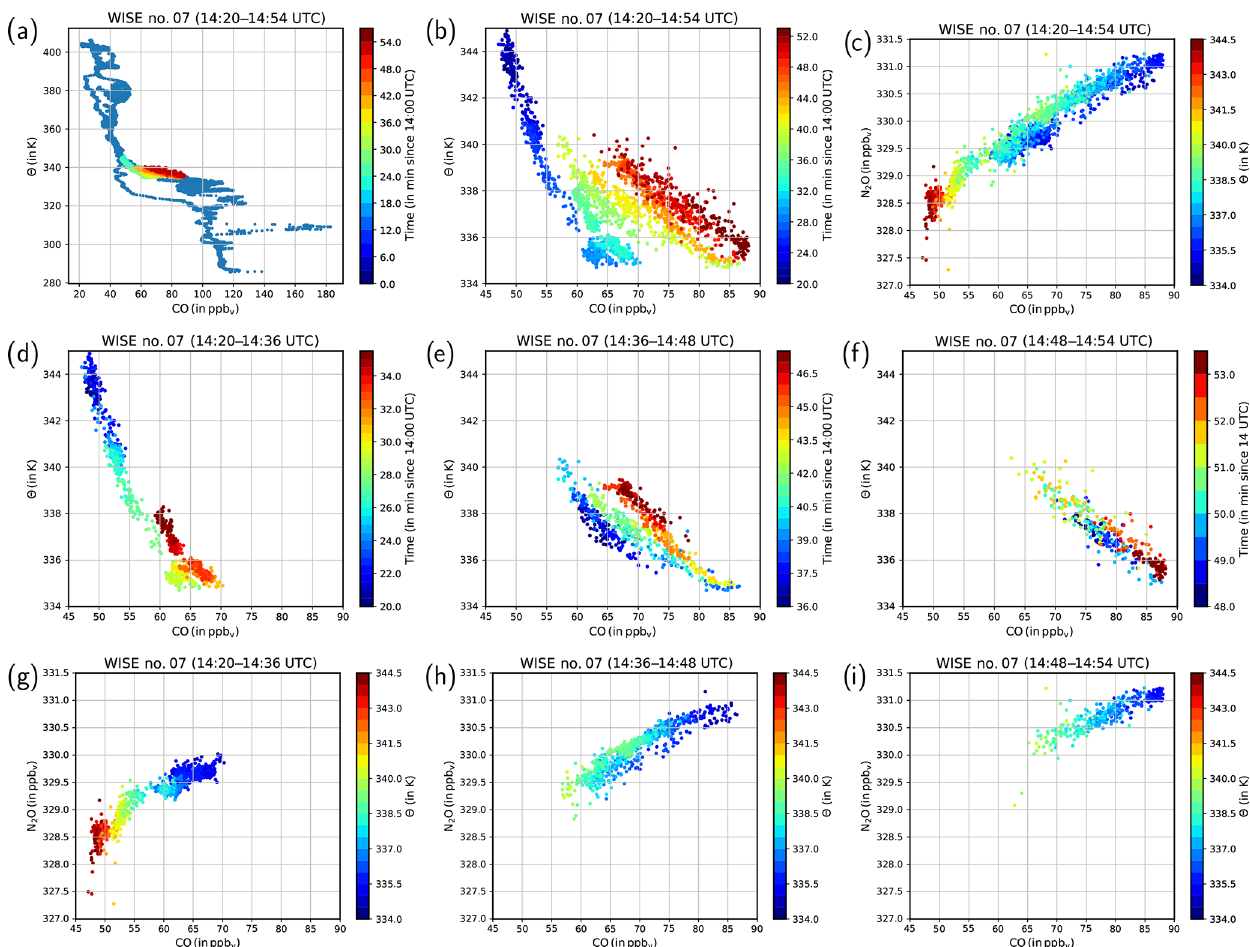
Figure 5. Trace gas analysis of the first southwestward leg on FL380, i.e., 205hPa of WISE RF07. (a) Vertical profile of carbon monoxide for the entire flight (blue dots) and color-coded for the leg on FL380. (b) Vertical profile of CO for the time period 14:20–15:00UTC, color- coded with time since 14:00UTC. (c) CO–N 2 O correlation for the time period 14:20–15:00UTC, color-coded with potential temperature. (d–f) Vertical profiles of CO for time periods 14:20–14:36, 14:36–14:48, and 14:48–14:54UTC, color-coded with time. (g–i) CO–N 2 O correlations for the time periods 14:20–14:36, 14:36–14:48, and 14:48–14:54UTC, color-coded with potential